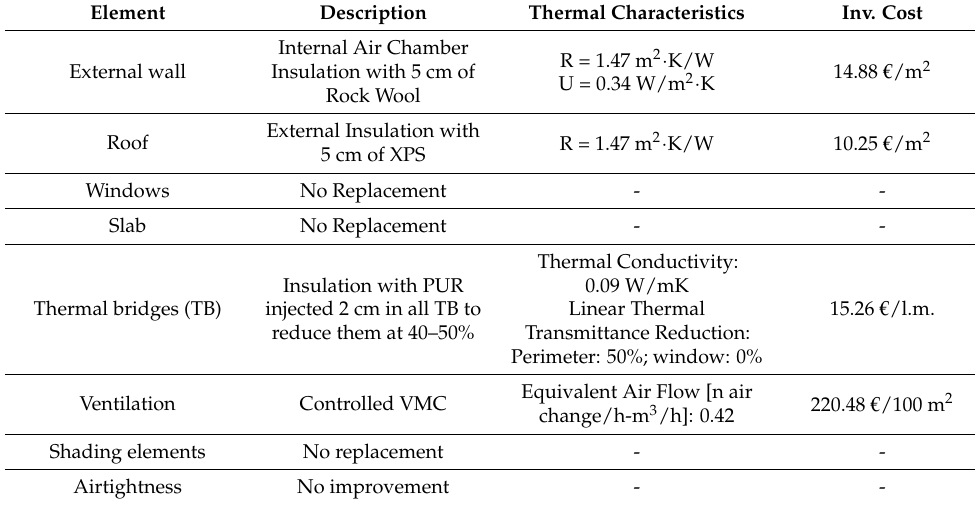
Table A4. POS5: Renovation measures of solution 6.